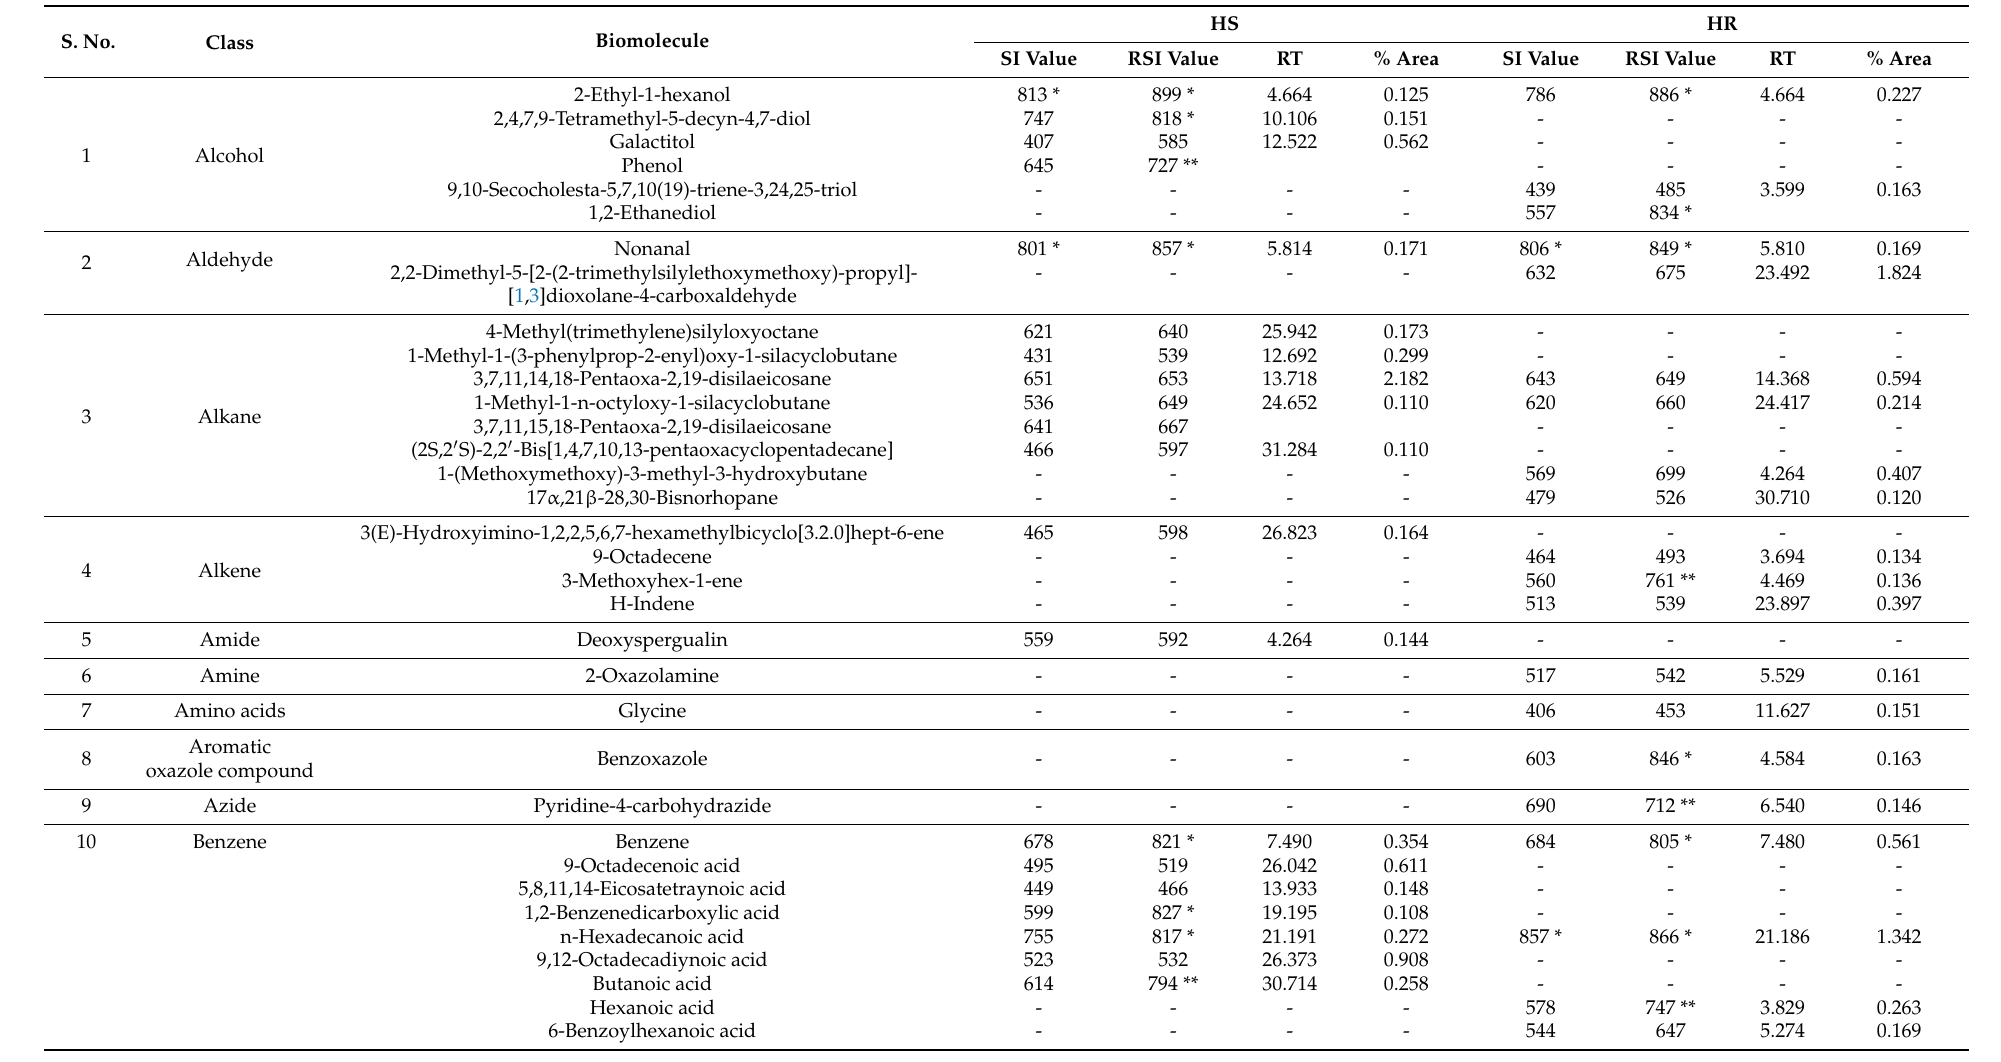
Table 4. The goodness of fit of the extracted biomolecules from HgYMV HR and HS genotypes based on SI and RSI values. S.